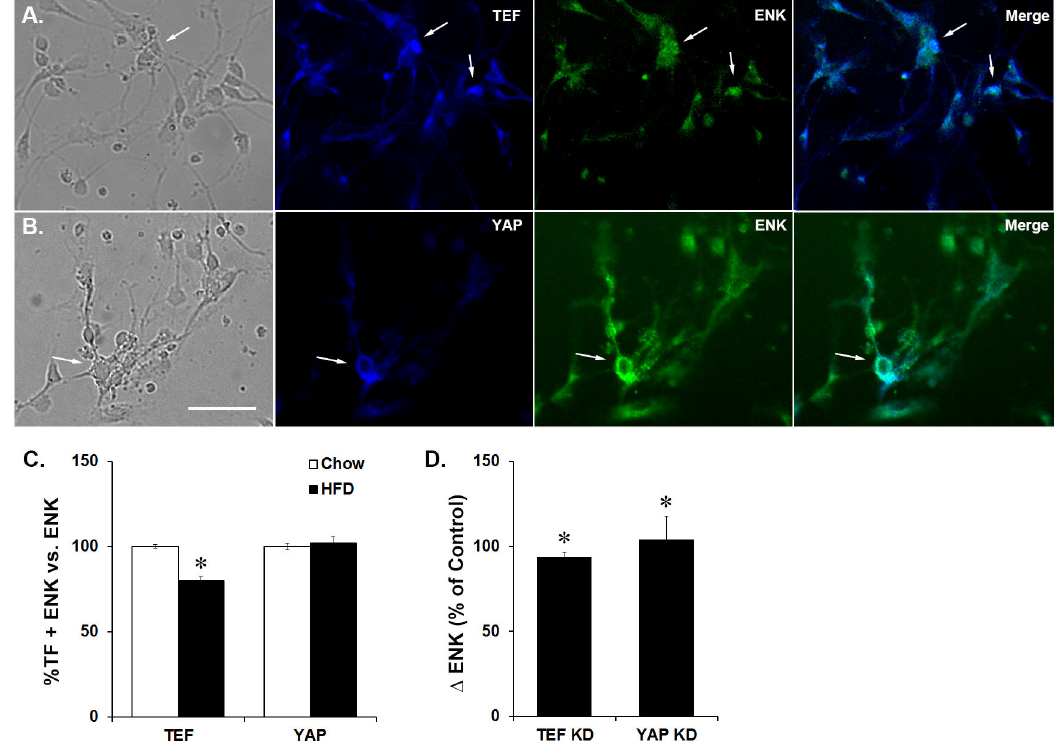
Figure 6. Co-localization of TEF or YAP with ENK. Immunocharacterization of dissociated hypothalamic neurons from E19 embryos co-labeled with (A) TEF and ENK and (B) YAP and ENK. (C) In HFD embryos, there was a significant decrease in the density of co-labeled TEF and ENK neurons but no change in the density of co-labeled YAP and ENK neurons. (D) Knockdown of either TEF or YAP with siRNA results in a significant increase in ENK expression. Representative images of neurons are from HFD embryos. Arrows point to the same cell from images left to right (DIC, fluorescence and merged images). Results are expressed as means ± SEM (n = 4). * p < 0.05, compared with chow. TF = transcription factor; KD = knockdown; scale bar is 25